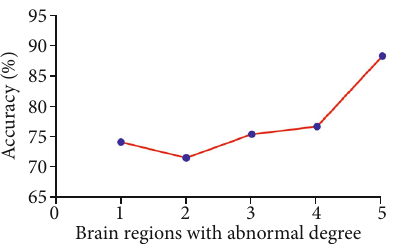
Figure 2: Accuracy of SVM using the fi ve brain regions with abnormal degree values to separate OCD from HCs. The SVM result showed that the highest accuracy is 5. 1=left cerebellum Crus I, 2=right precuneus, 3 =left dorsolateral prefrontal cortex, 4 =left postcentral gyrus, and 5=left thalamus. SVM =support vector machine; OCD =obsessive-compulsive disorder; HCs= health